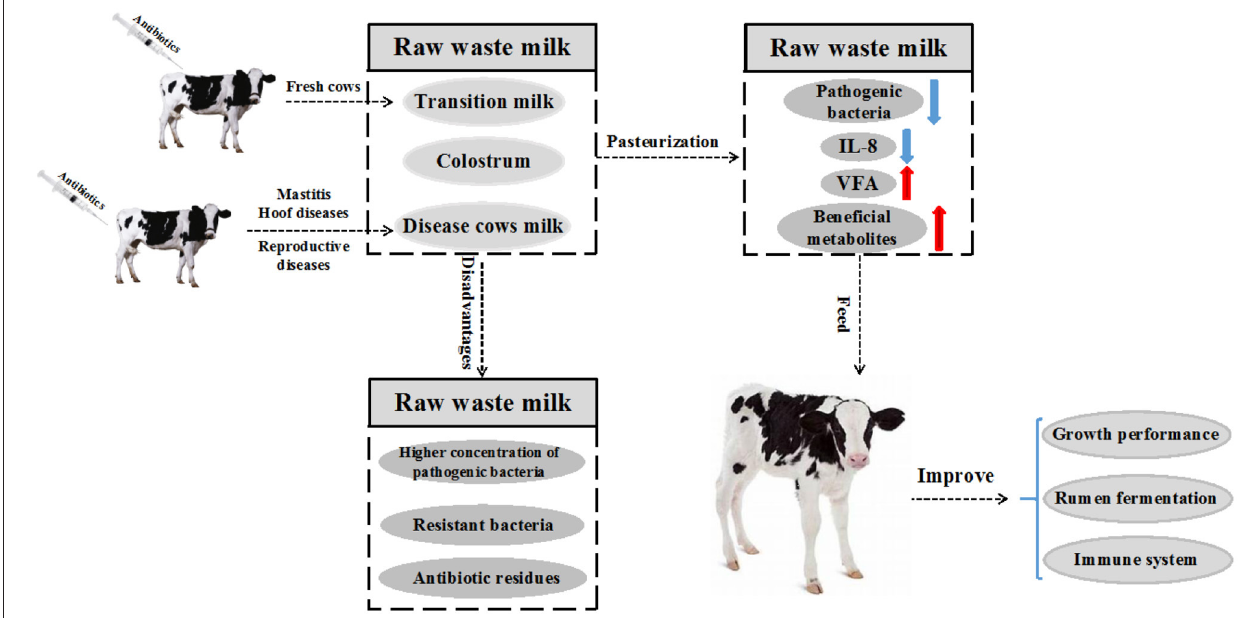
FIGURE 1 | Raw waste milk (WM) refers to milk that cannot be sold to the market for human consumption. The milk is obtained mainly from fresh cows and diseased cows under treatment with antibiotics or whose antibiotic withdrawal period has not elapsed, resulting in very low concentrations of these antibiotics being passed through milk. Pasteurization is often performed before feeding WM to reduce health risks in calves. Pasteurized WM reduces the number of harmful bacteria, IL-8 and increases the concentration of beneficial metabolites and volatile fatty acids (VFA). Finally, the growth performance, rumen fermentation and immune system of the calves are